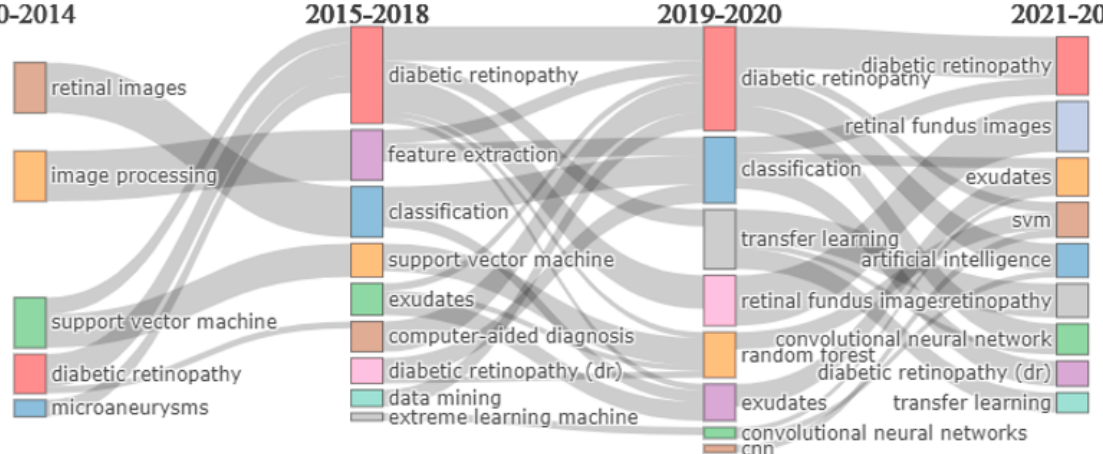
Figure 17. Thematic evolution of the author keywords.